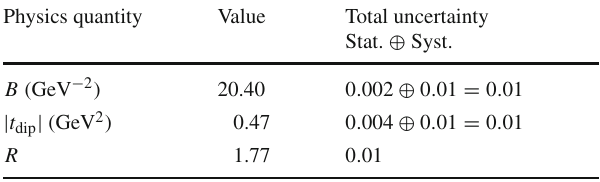
Table 4 The main physics observables and their statistical and system- atic uncertainty Physics quantity Value Total uncertainty